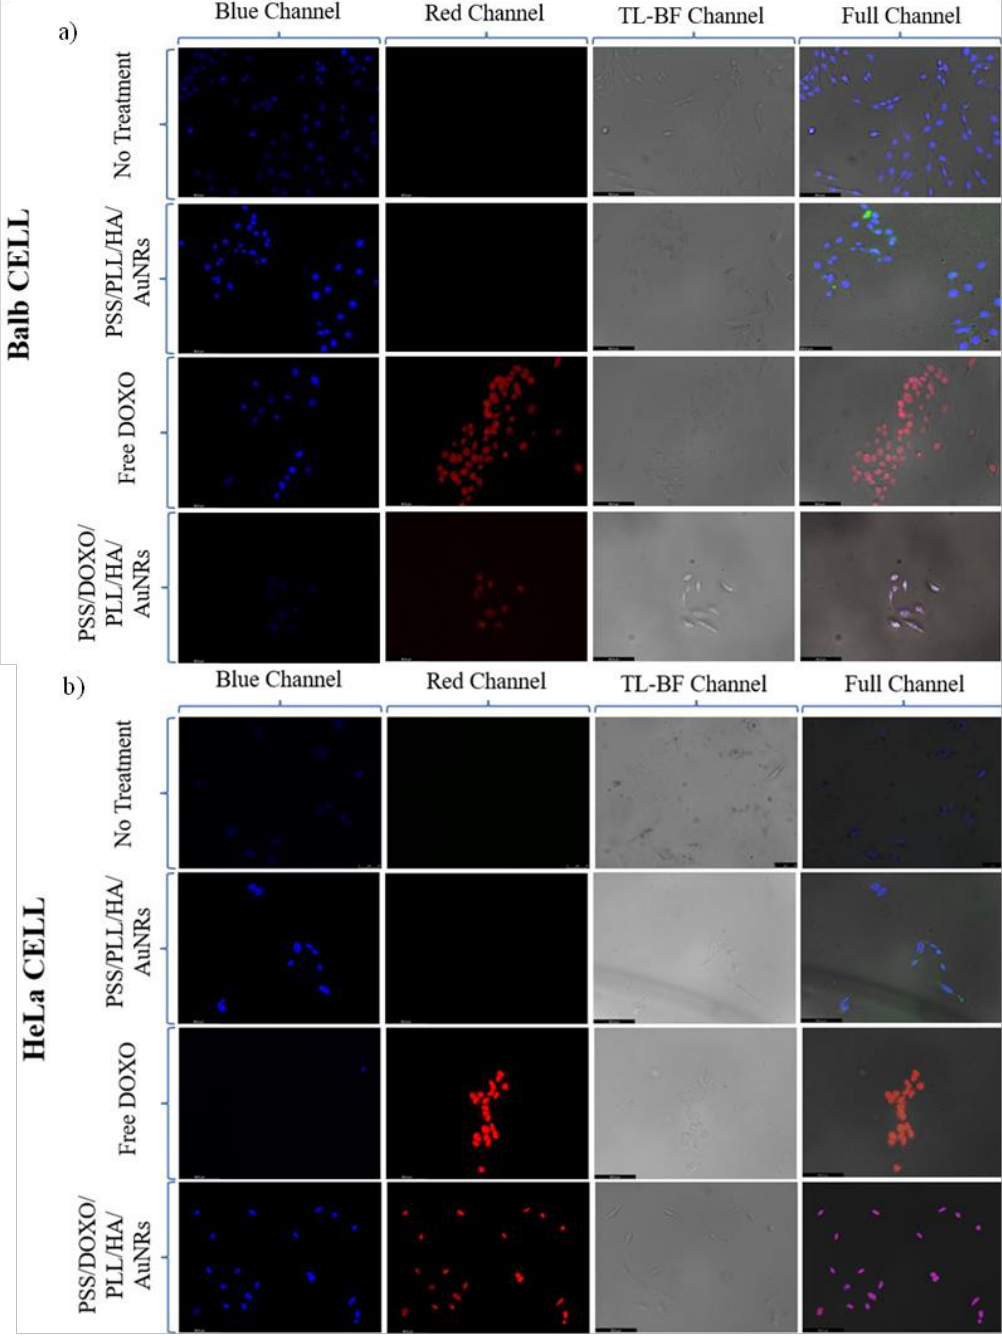
Figure 6. Fluorescence microscopy images of PSS/DOXO/PLL/HA-coated AuNRs inside ( a ) 3T3 Balb and ( b ) HeLa cells at 12 h of incubation. Images shown blue, red and bright field channels, as well as the merged images: Blue channel displays cell nuclei stained with DAPI (λ ex = 355 nm); the red one DOXO fluorescence (λ ex = 488 nm), and the bright field the optical image. Scale bars are 10 µm.